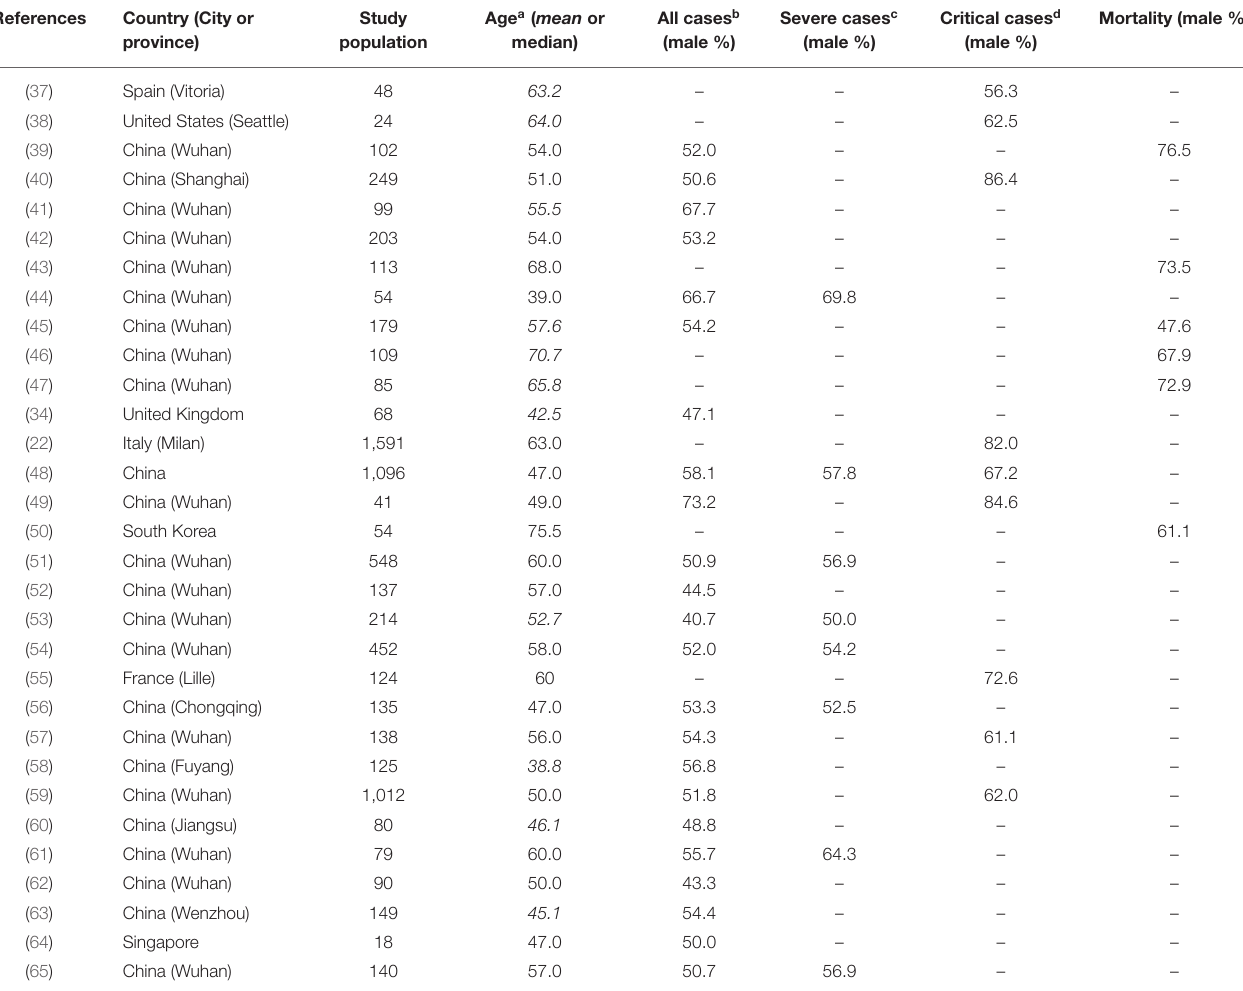
TABLE 2 | Demographics of all studies included in the meta-analysis with sex-specific disease